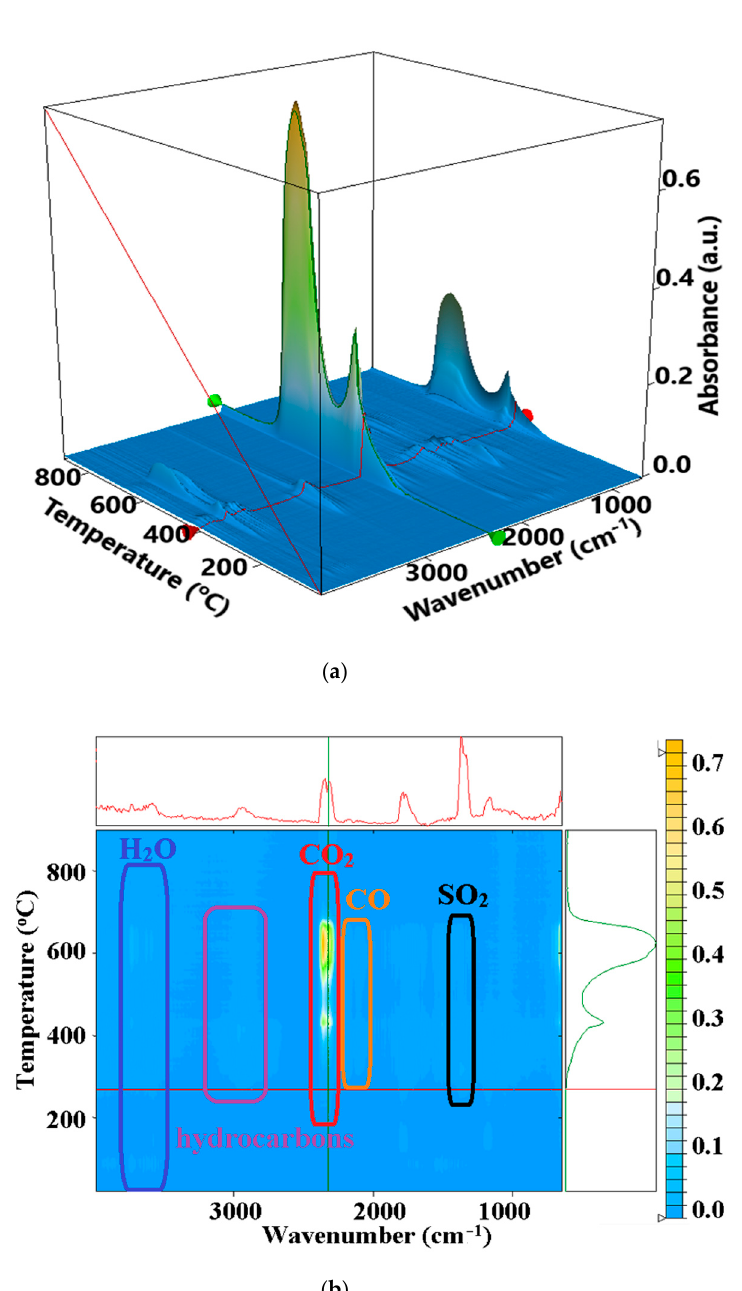
Figure 11. The evolved gases’ FTIR 3D diagram for the PCS sample ( a ); and its 2D projection with assigned identification/temperature intervals ( b ).